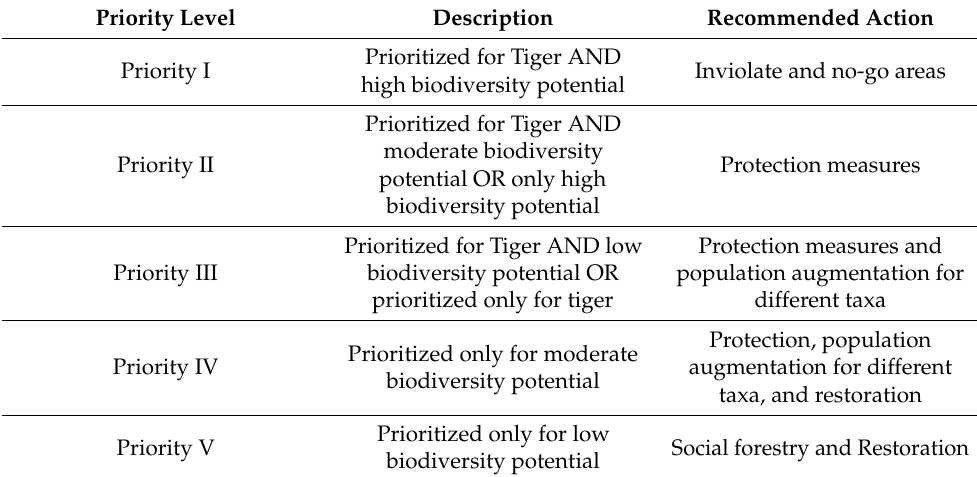
Inviolate and no-go areas Protection measures Protection measures and population augmentation for different taxa Protection, population augmentation for different taxa, and restoration